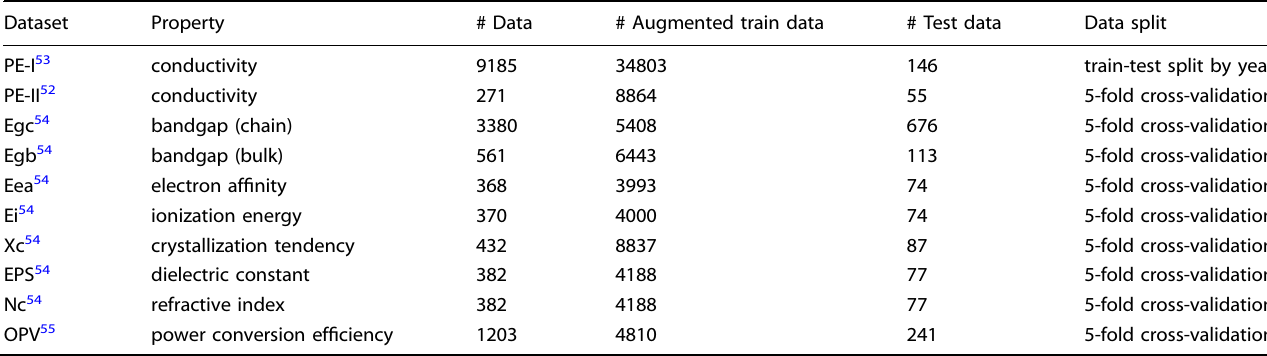
Table 1. Summary of datasets for downstream tasks.